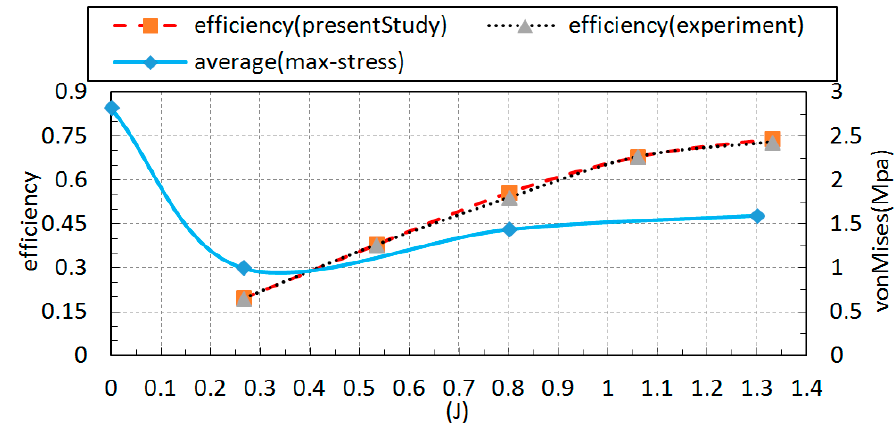
Figure 9. The comparison between a maximum stress and hydrodynamic efficiency.